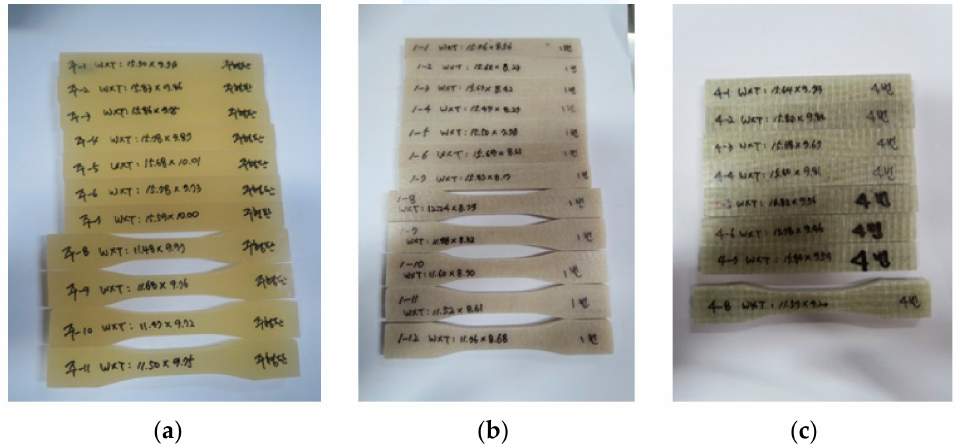
Figure 1. Cured-in-Place Pipe (CIPP) Samples for Mechanical Test: ( a ) Resin (Group No. 1); ( b ) Felt with Glass Fiber (Group No. 5); and ( c ) Glass Fiber (Group No. 2).